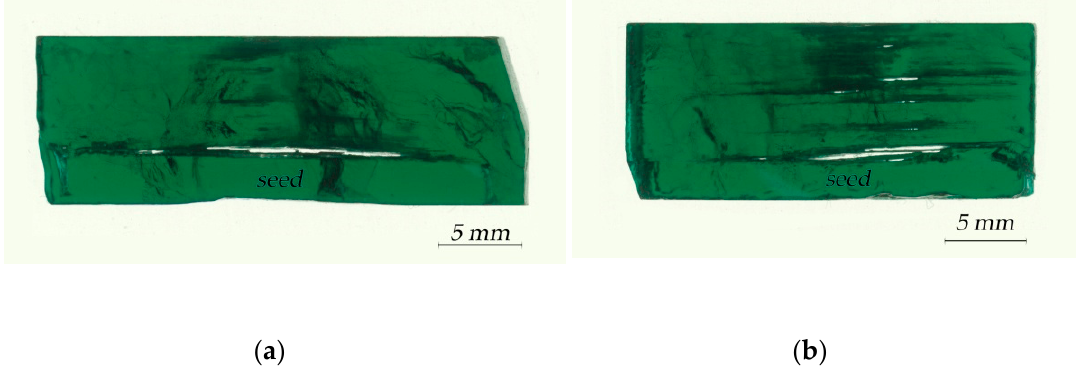
Figure 4. Crystals grown in unsuitable growth conditions. Photographs of samples from crystals #7 ( a ) and #8 ( b ).